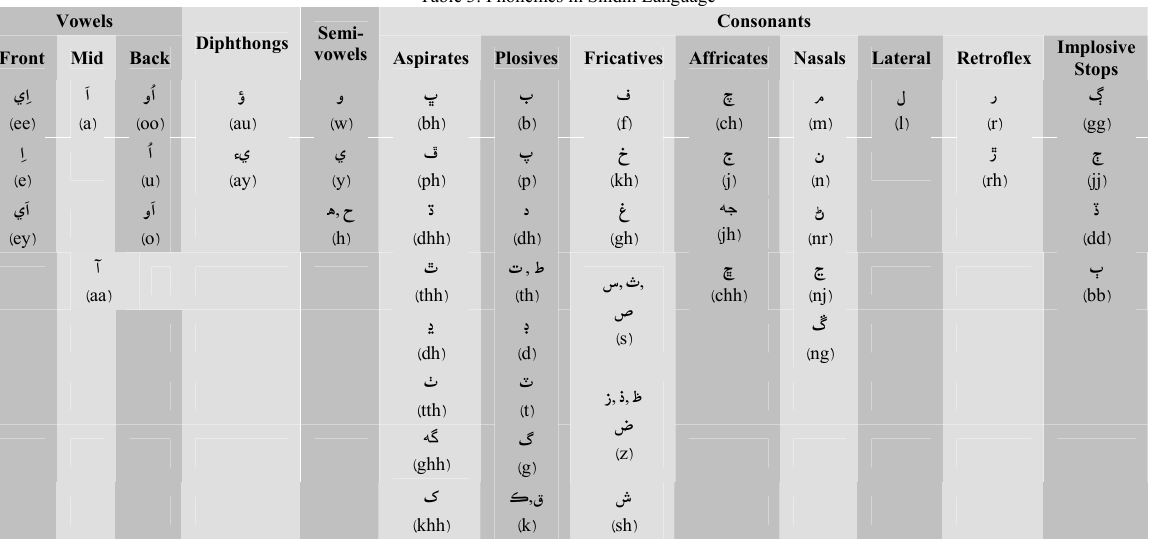
Table 3: Phonemes in Sindhi Language